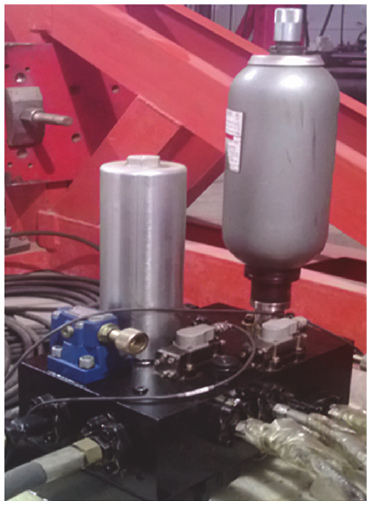
Figure 20: Hydraulic servo